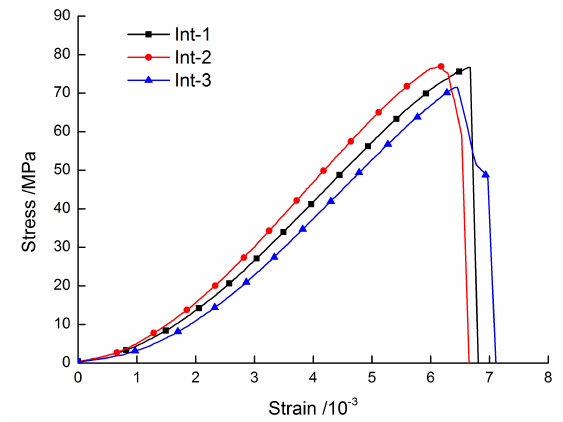
Figure 3. Effect of heterogeneity on axial stress–strain curves of sandstone specimens under uniaxial compression.